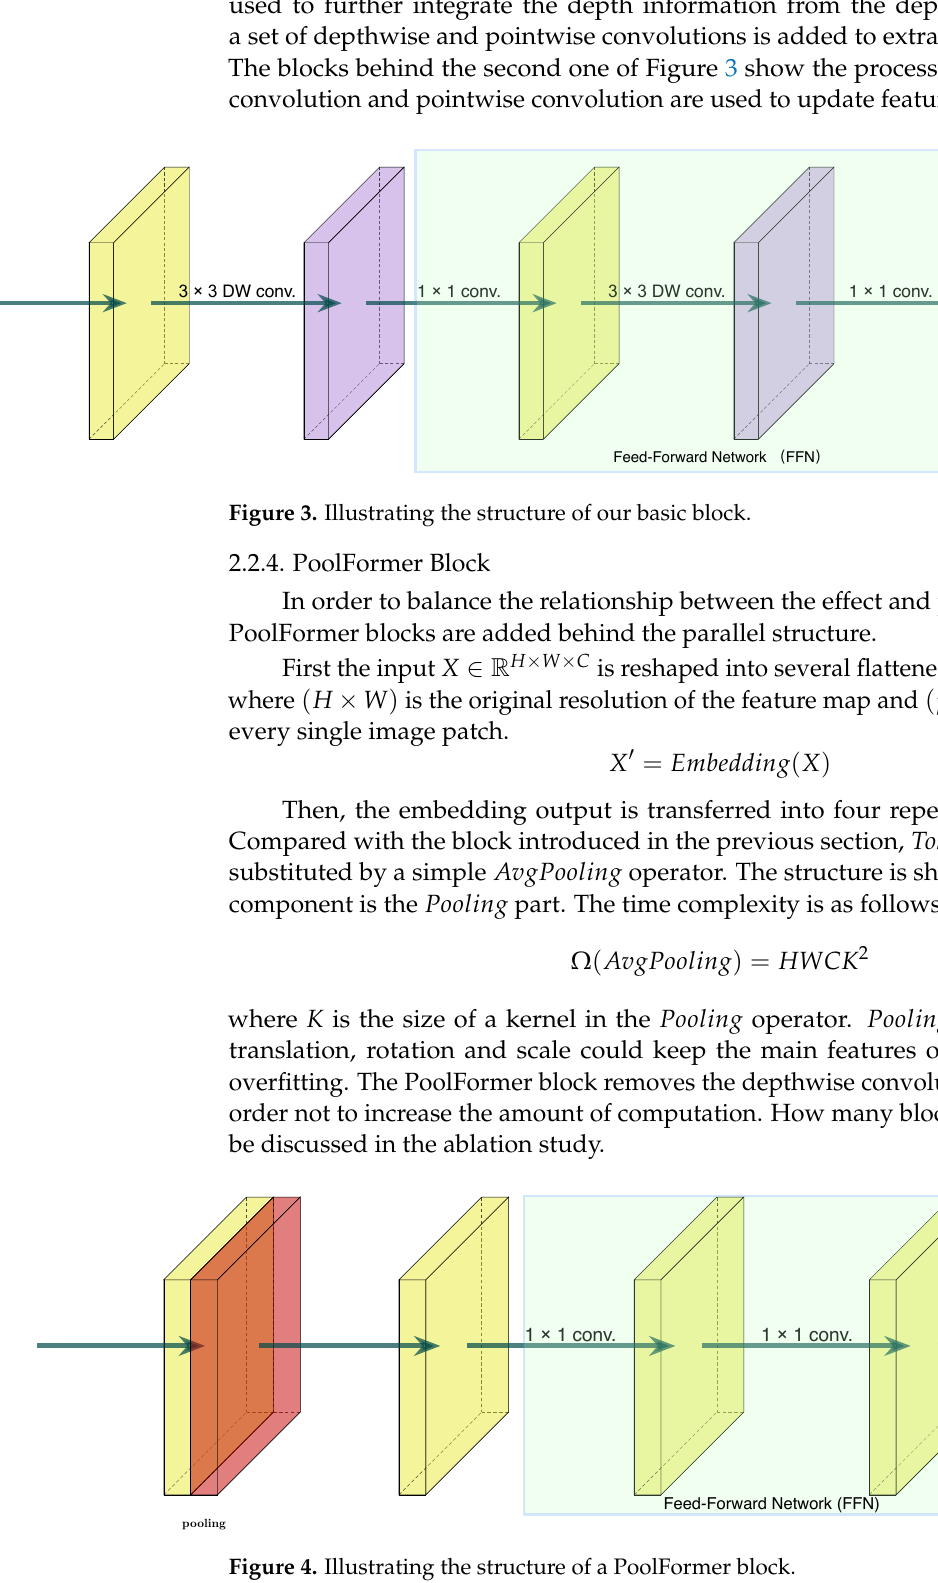
Figure 4. Illustrating the structure of a PoolFormer